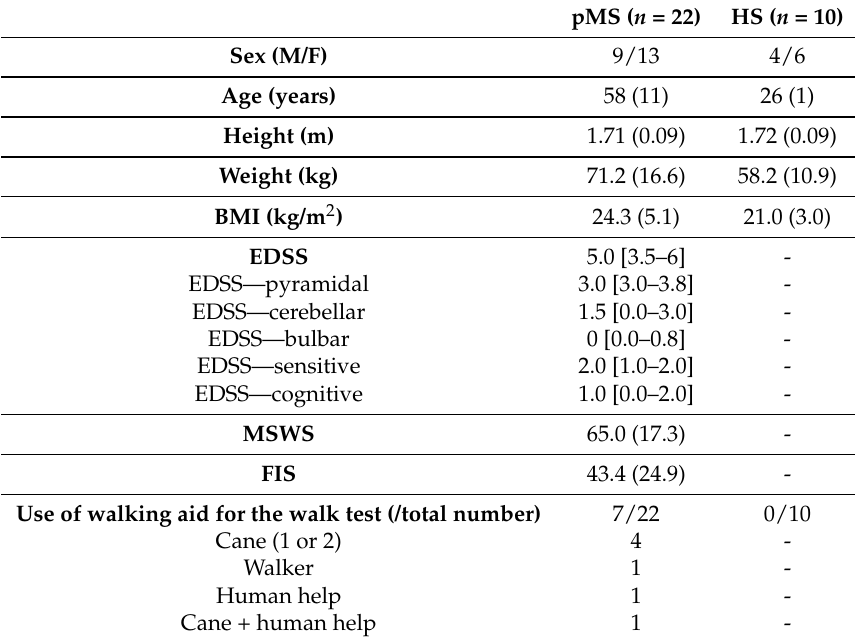
Table 1. Baseline characteristics of patients with progressive multiple sclerosis (pMS) and healthy subjects (HS). For the age, height, weight, BMI, Multiple Sclerosis Walking Scale (MSWS) and Fatigue Impact Scale (FIS), the mean and the standard deviation (SD) are displayed. For the Expanded Diseases Status Scale (EDSS) and the functional scores (subscores of EDSS), the statistics are reported as median and interval quartile range